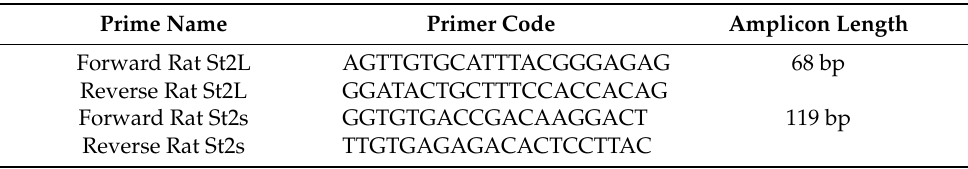
Table 2. Custom LNA oligonucleotide